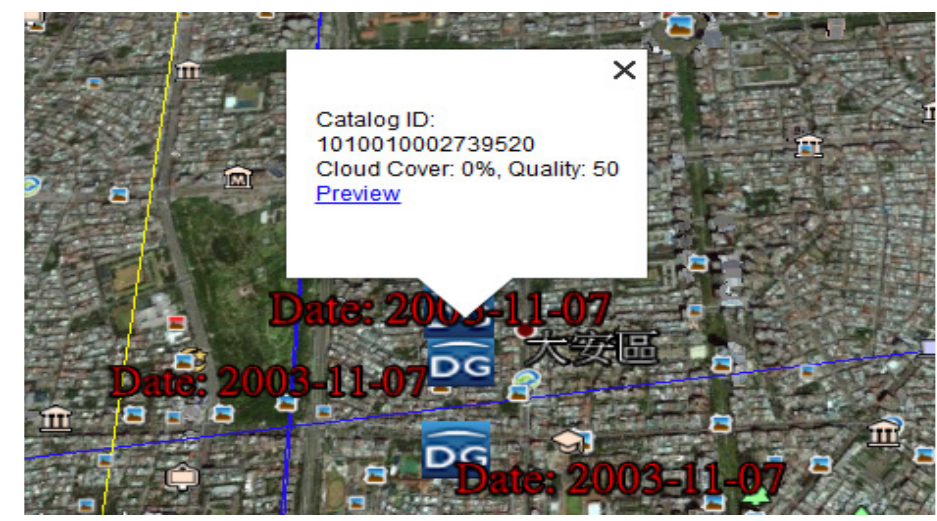
Figure A3. Open Preview to get the Avg Off Nadir Angle.